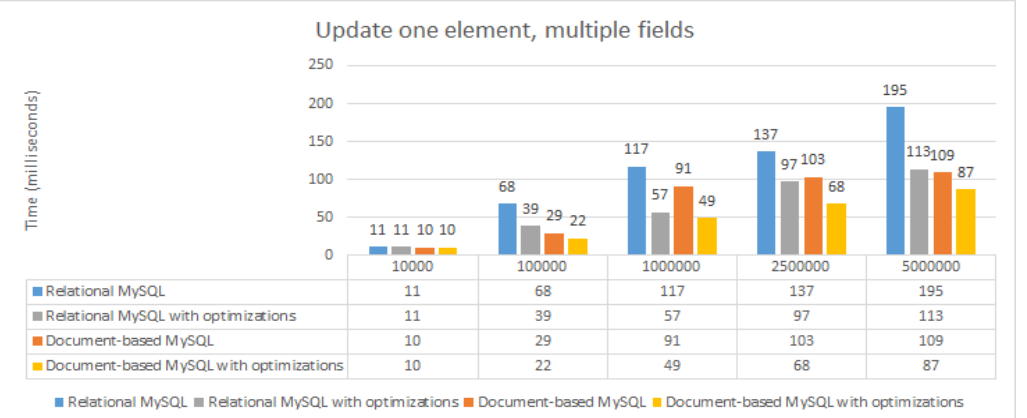
Figure 4. Performance time (ms) for the update one element and one field operation.